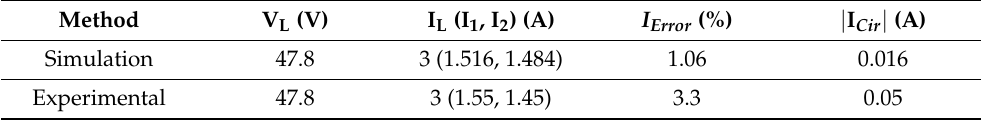
Table 13. Comparison of simulation and experimental results of proposed adaptive droop control for varying load and different cable